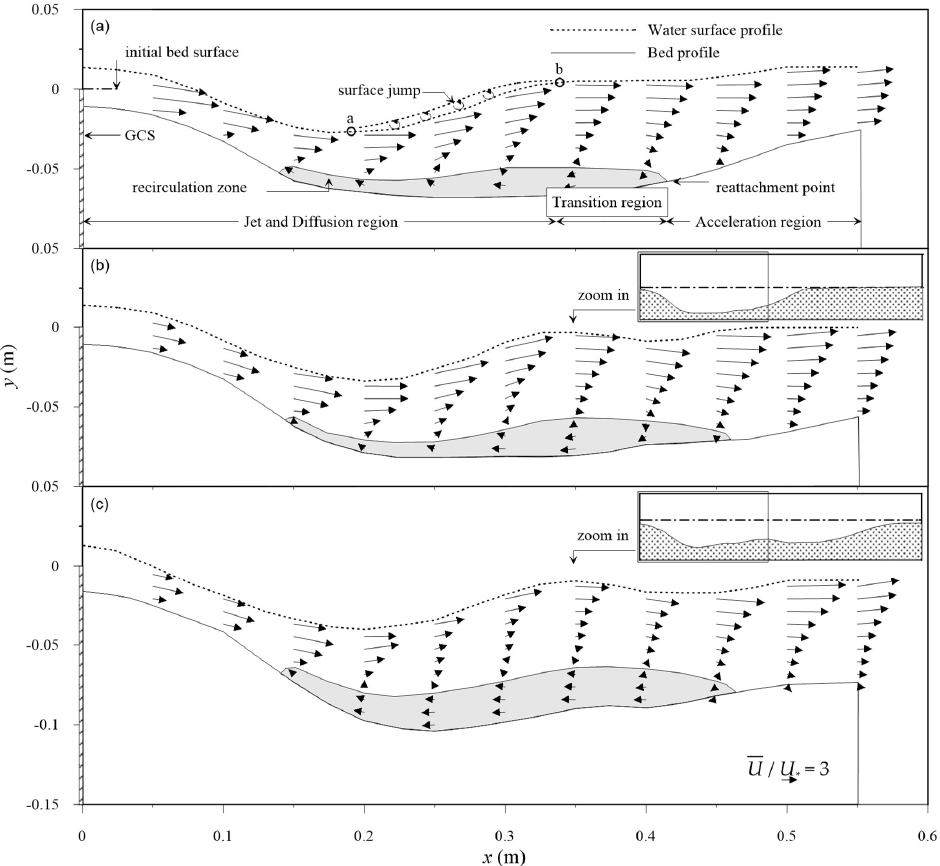
Figure 4. Measured vectorial mean velocity profiles in the scour hole for Run S-2: ( a ) T = 15 min, ( b ) T = 1 h, and ( c ) T = 5 h.